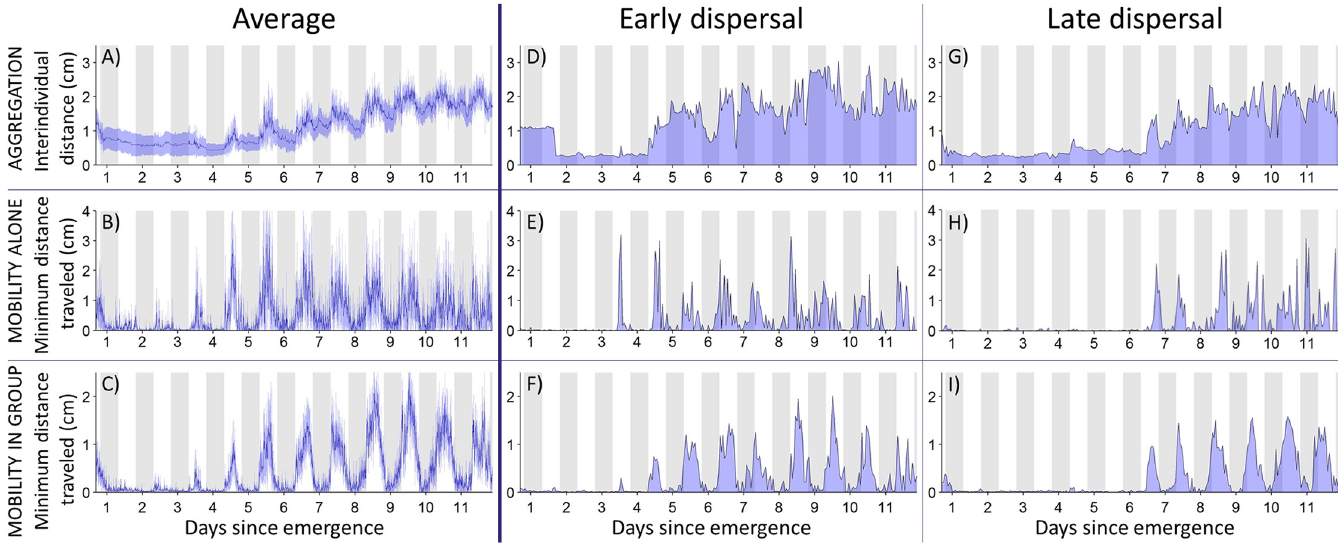
Fig 2. Within-cocoon synchronization and between cocoons variability in the onset of locomotion. The interindividual distance and the level of mobility were determined from the spatial coordinates of spiderlings introduced to dispersal arenas photographed every 10 min for 12 consecutive days. (A) Average ( ± 95% CI, N = 14) mean interindividual distances in groups of four spiderlings introduced to dispersal arenas. (B-C) Average ( ± 95% CI) activity level of siblings tested alone (B) ( N = 14) or in groups (C) ( N = 14). (D to I) Interindividual distance and mobility level in spiderlings from two representative cocoons differing in their timing of dispersal. Relevant data values are included in S2 Data. The grey shading indicates nocturnal phases.